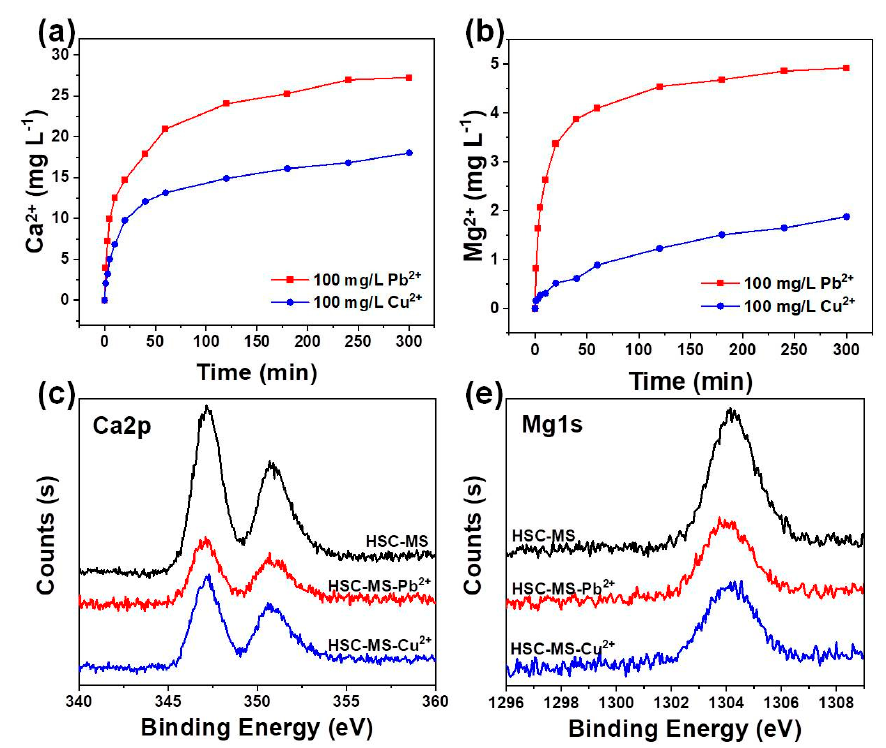
Figure 12. The concentration of Ca 2+ ( a ) and Mg 2+ ( b ) released in the adsorption process. High-resolution XPS spectra on the ( c ) Ca2p and ( d ) Mg1s of HSC-MA-2 before and after Pb 2+ and Cu 2+ adsorption.